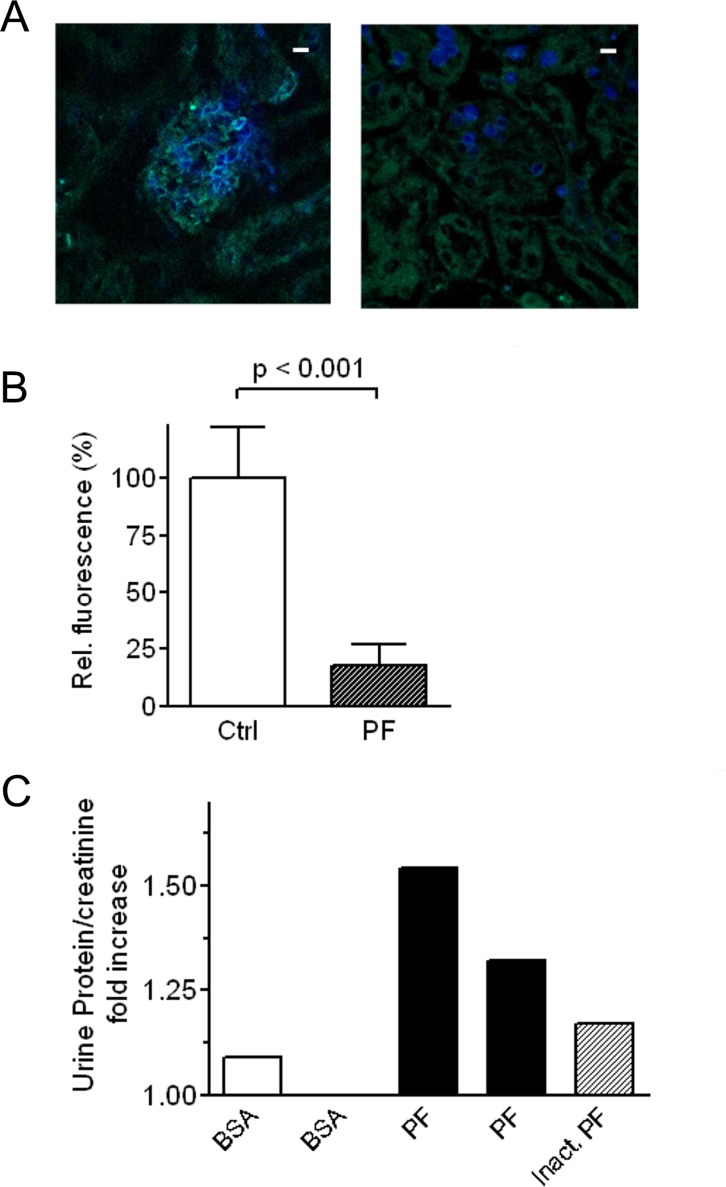
Effect of in vivo injection of PF on the glomerular expression of nephrin and urine protein/creatinine ratio.(A) Micrographs representative of immunofluorescence staining for nephrin in glomeruli from female SCID mice injected in vivo with PF (left image) or, as negative control, heat-inactivated PF (right image) (x63). Bars = 10 μm.(B) Semiquantitative analysis of nephrin expression as detected by immunofluorescence staining in glomeruli from female SCID mice injected in vivo with PF or, as negative control, heat-inactivated PF (Ctrl). At least five animals were studied per each experimental group. (C) Urine protein/creatinine ratio 24 hours after a single injection of PF (black bars) or heat-inactivated PF (dashed bar) in female SCID mice. Each bar is representative of a single experiment.